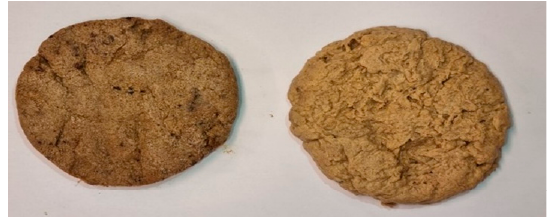
Figure 4. Vegetarian ( left ) and vegan ( right ) burger patties before frying.